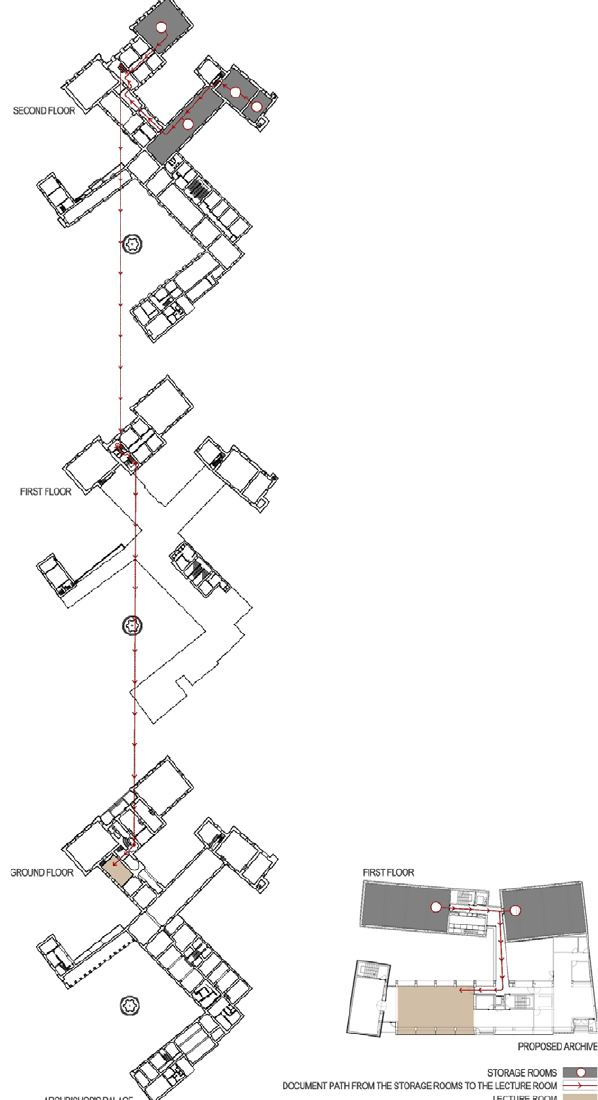
Figure 15. Comparison between the existent and the proposed documents’